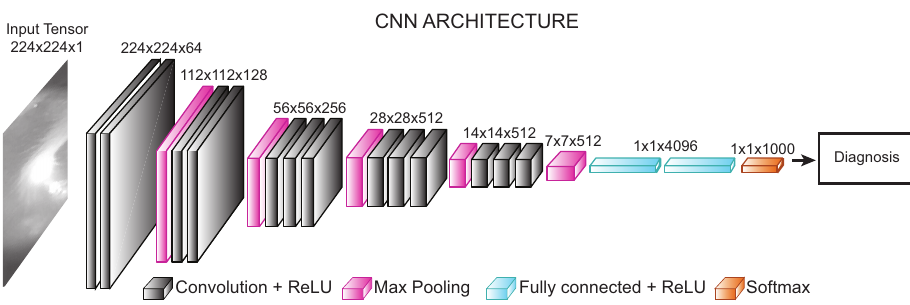
Figure 3. Convolutional neural network architecture for image classification. First convolutional layers extract low-level features such as edges, corners, or lines from the image. The last convolutional layers recognize structures and larger shapes in the input data. Each convolutional layer generates a feature map X l − 1 by convolving the input with the learnable kernels k l